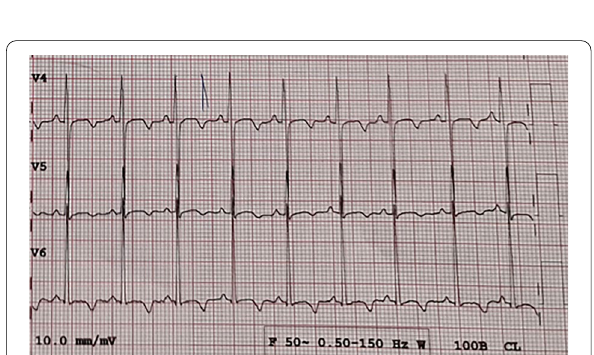
Fig. 2 T wave inversion in left precordial leads of the electrocardiogram of the